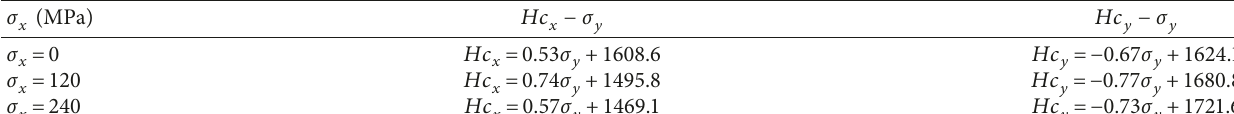
Table 1: Hc − σ y fitting formula under different σ x of test piece